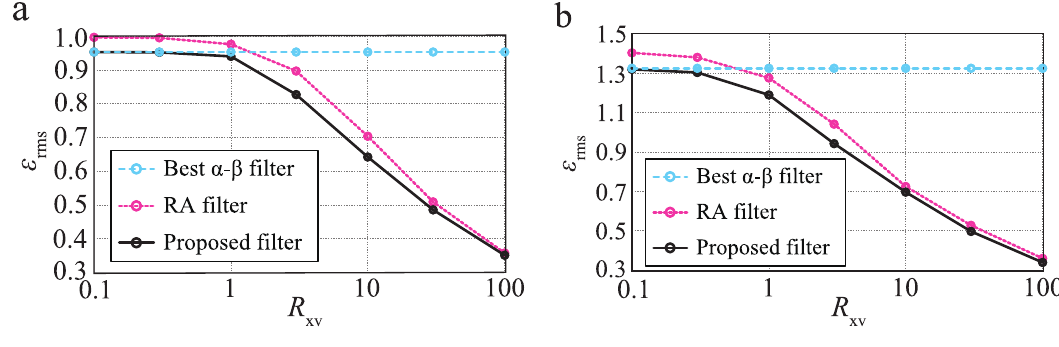
= 0.01 and ( b ) a 2 D